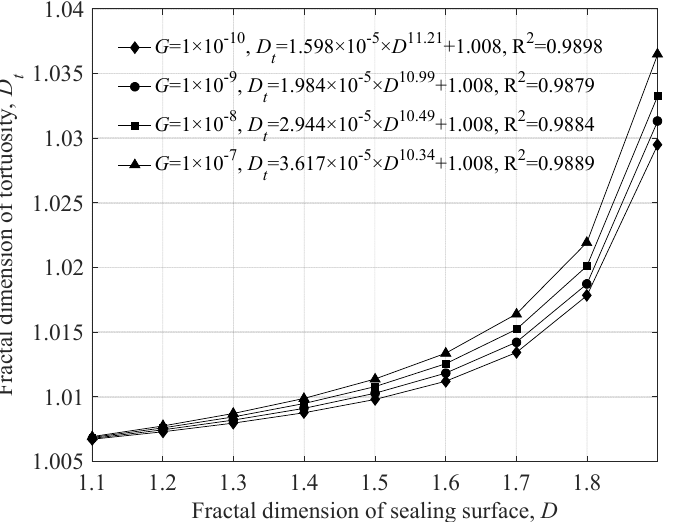
Figure 15. The influence of sealing surface fractal parameters on tortuosity fractal dimension.